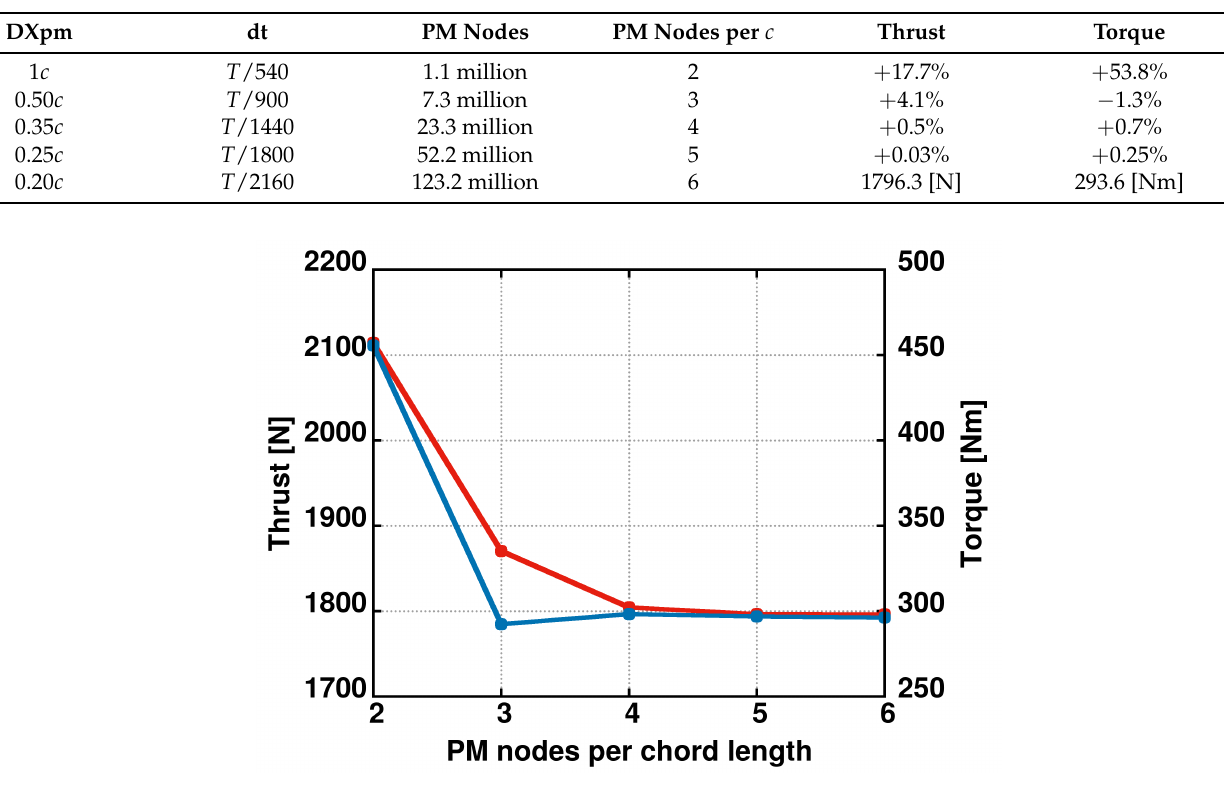
Figure 8. Thrust (N) and Torque (Nm) estimation with respect to the number of PM nodes per chord length. Table 6. Normalized aerodynamic load estimation at 60% R provided by different PM discretisation lengths. Reference values correspond to minimum value DXpm = 0.20 c